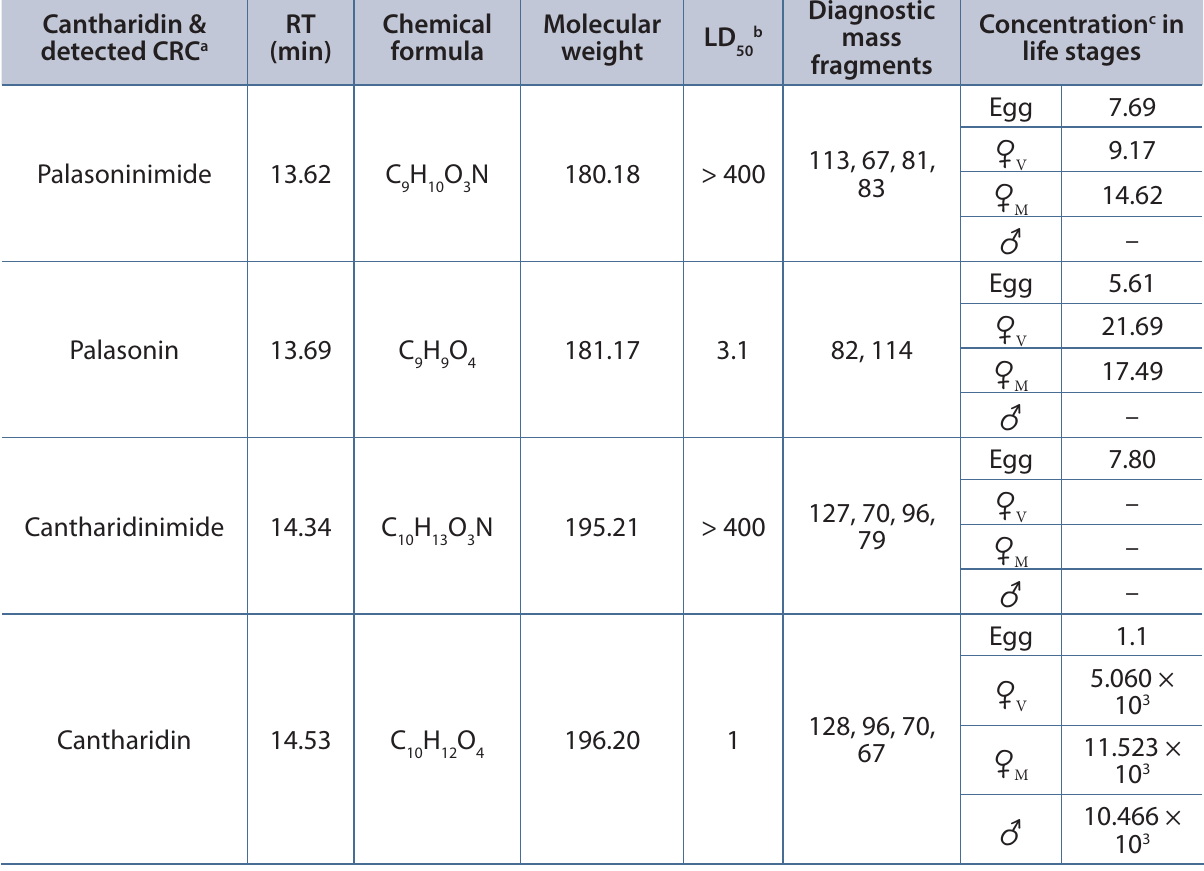
Table 1. Physicochemical properties, toxicities and measured concentrations of cantharidin and CRCs in Hycleus scabiosae (Coleoptera: Meloidae), based on quantitative gas chromatography/electron impact mass spectrometry Cantharidin